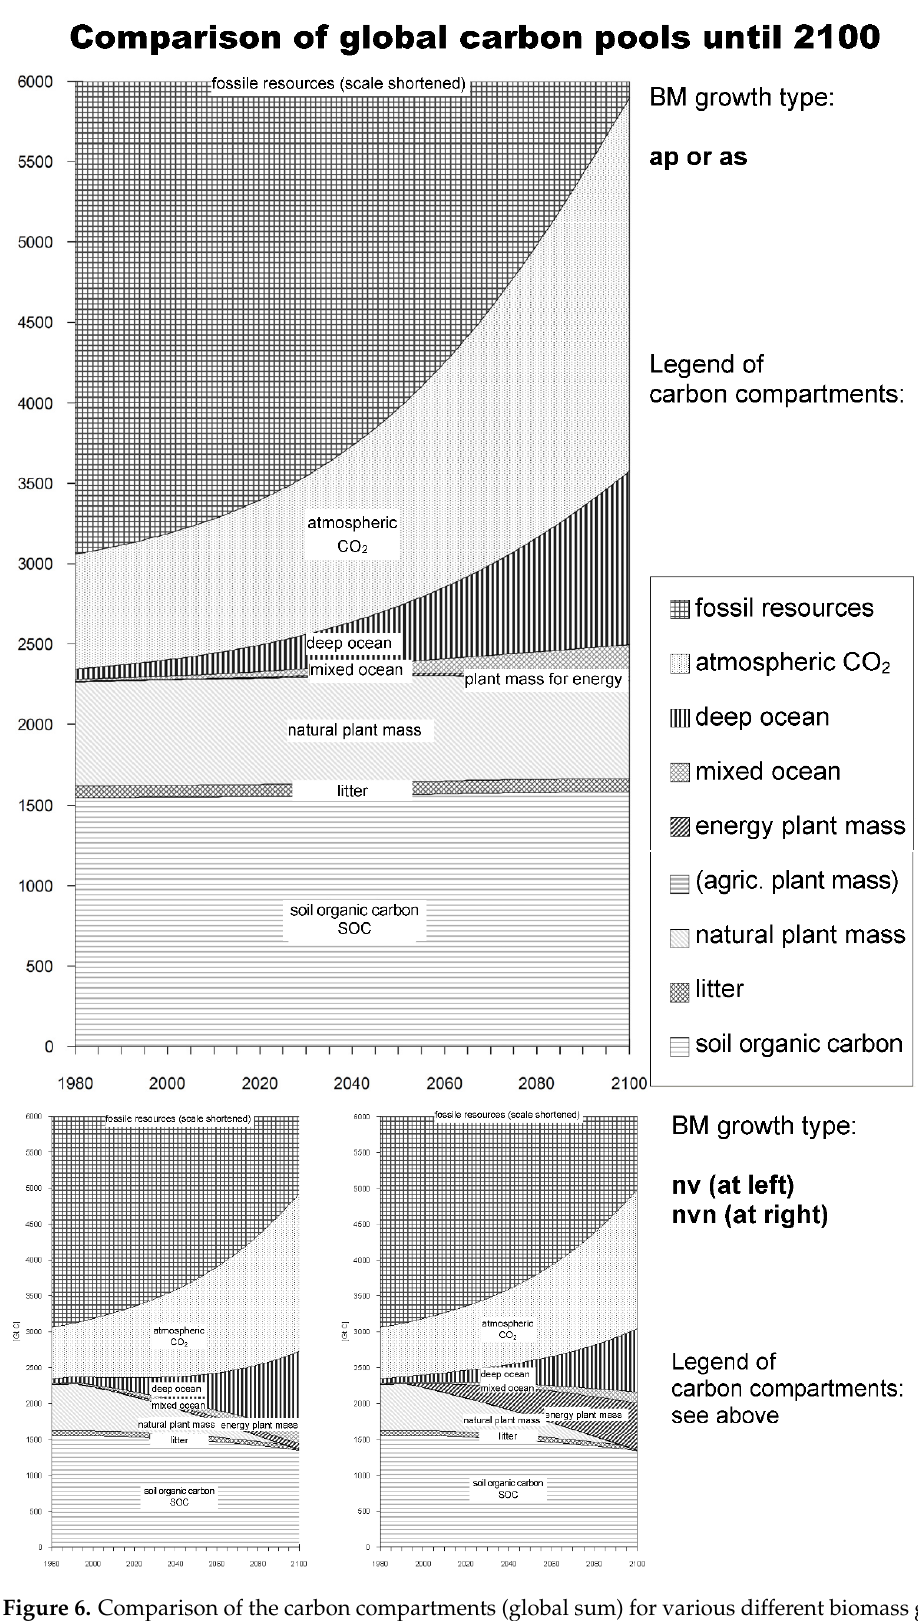
Figure 6. Comparison of the carbon compartments (global sum) for various different biomass growth types, assuming 3% annual increase in fossil energy consumption: above: ap (=energy plantation on agricultural areas) or as (=energy use of agric. BM), bottom left: nv (=energy use of natural biomass, age = 5 years) and bottom right: nvn (=energy use of natural